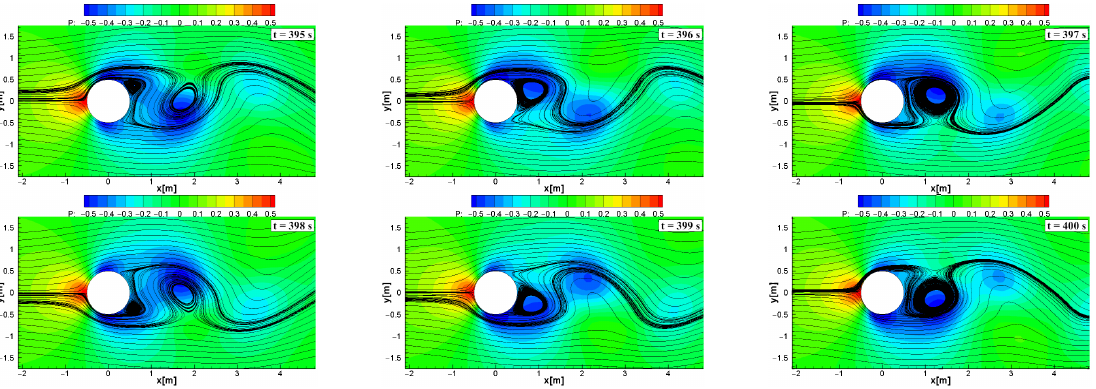
Figure 13. Contour maps of pressure and streamlines around a circular cylinder during approximately one cycle of vortex shedding ( Re = 100).